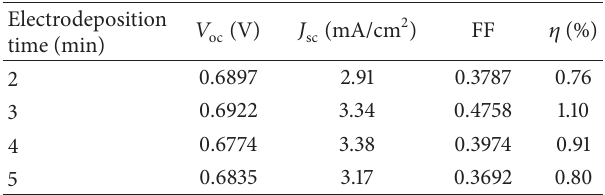
Table 2: Theparameters ofDSSCs underdifferent electrodeposition